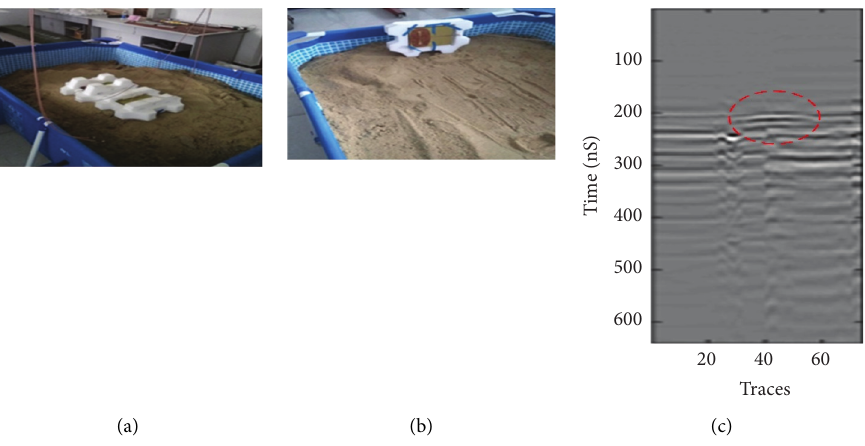
Figure 15: The block diagram of GPR test arrangement in the